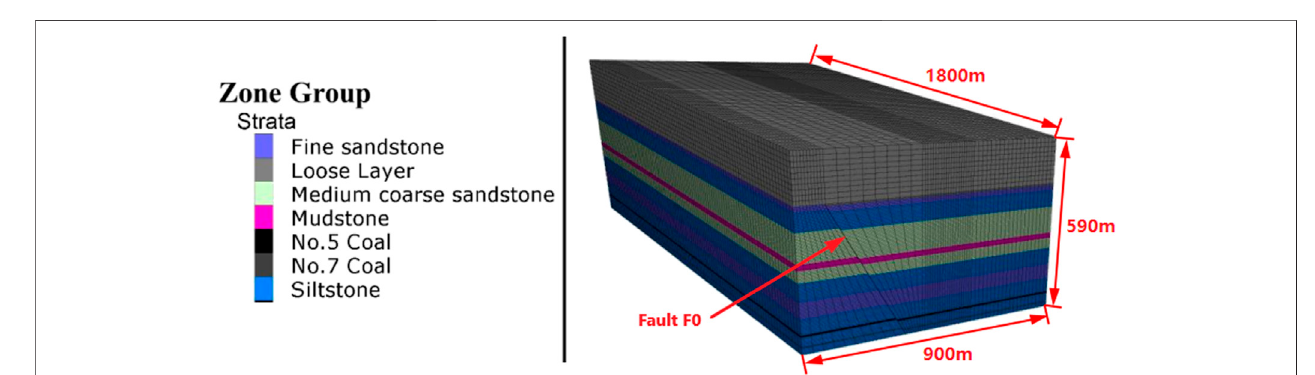
FIGURE 3 | FLAC 3D FDM